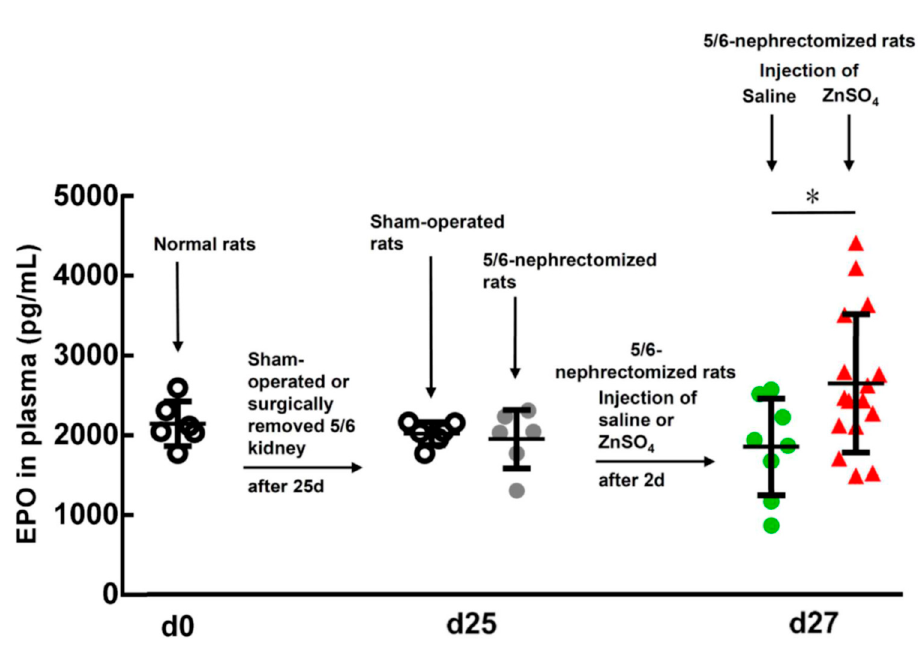
Figure 3. EPO levels in the plasma of normal and saline- or ZnSO 4 -injected 5 / 6-nephrectomized rats (27 days post surgery). EPO levels in the plasma of the rats before and after the experiment were measured using an enzyme-linked immunosorbent assay (ELISA) kit. * Significant di ff erence ( p = 0.014) between saline ( n = 8)- and ZnSO 4 ( n = 17)-injected 5 / 6-nephrectomized